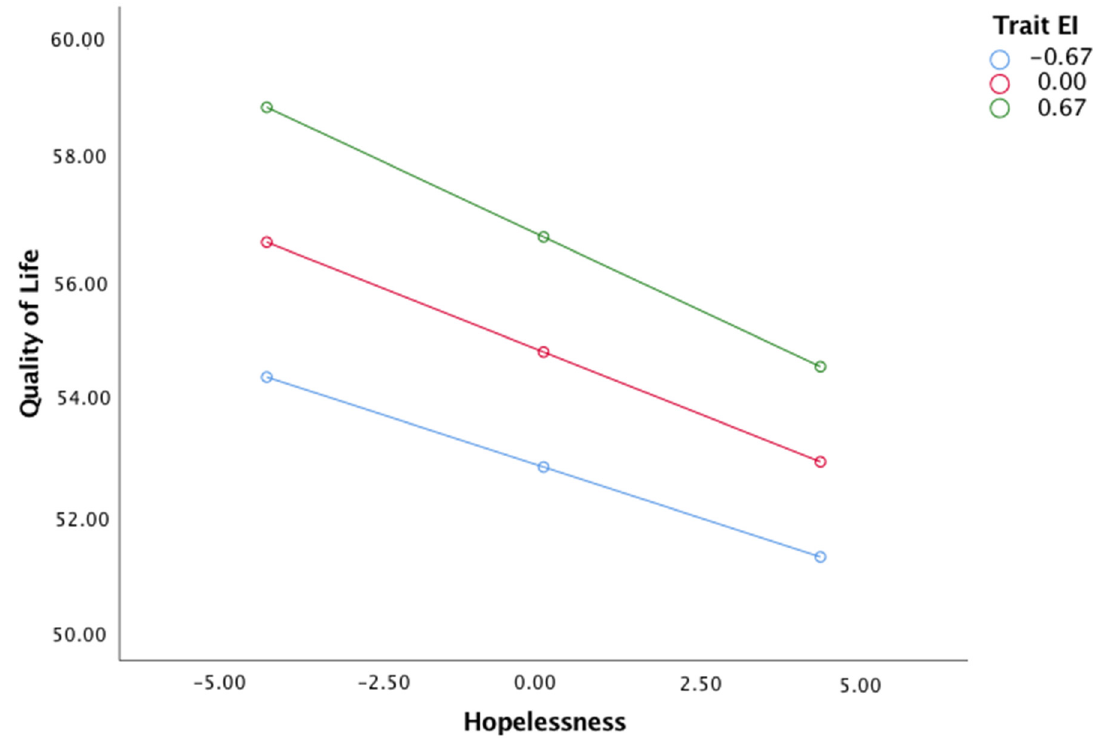
Figure 2. Data plot of simple slope interaction for hopelessness × trait EI on Quality of Life. The simple slope for high (+1 SD ), moderate, and low ( − 1 SD ) levels of trait EI were (B = − 0.51, p < 0.001, 95% confidence interval = [ − 0.65, − 0.36]), (B = − 0.43, p < 0.001, 95% confidence interval = [ − 0.53, − 0.33]), and (B = − 0.35, p < 0.001, 95% confidence interval = [ − 0.45, − 0.25]), respectively.